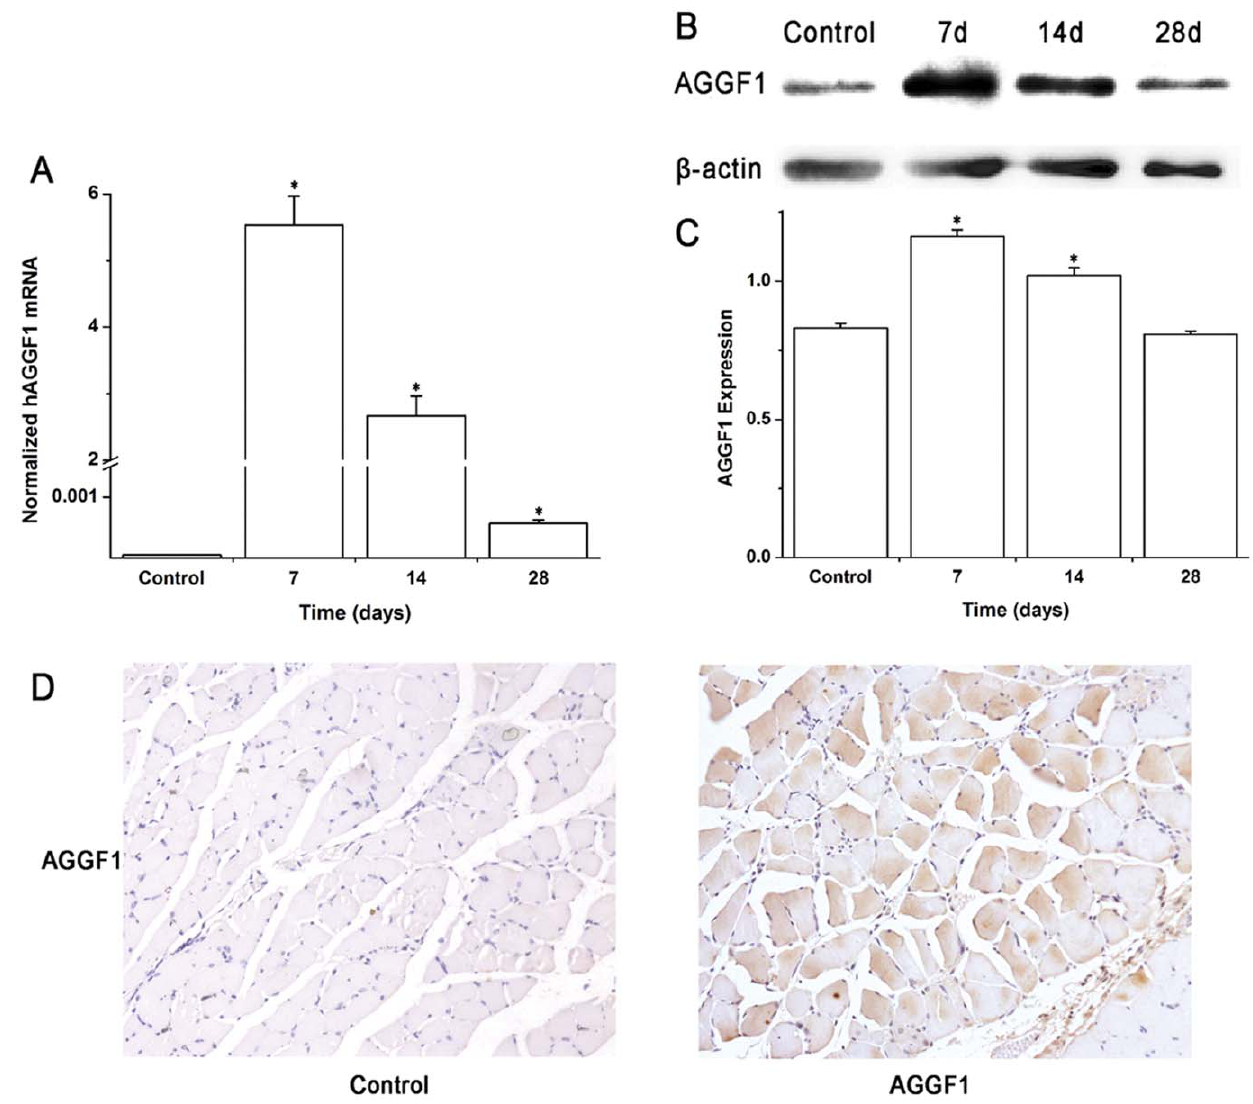
Figure 1. Successful overexpression of AGGF1 mRNA and protein in skeletal muscle by gene transfer using a plasmid-based delivery system. A) Real time PCR analysis for expression of human AGGF1 mRNA derived from an AGGF1 expression plasmid injected into the gastrocnemius muscle in a mouse ischemic hindlimb model. The RT-PCR primers are specific to human AGGF1 and not able to amplify the endogenous mouse AGGF1 mRNA. Time points are in days after the injection of plasmid DNA. Injection of the empty vector DNA served as negative control. The data are shown as the amount of plasmid-derived human AGGF1 mRNA normalized to control GAPDH levels. To avoid the contamination of plasmid DNA, RNA samples were treated with DNase. In addition, RT-PCR analysis with RNA samples without reverse transcription did not yield any product. B ) Expression of AGGF1 protein in gastrocnemius muscles by Western blot analysis at time points of 7, 14, 28 days after plasmid DNA was injected. The anti-AGGF1 antibody recognizes both human AGGF1 derived from the injected plasmid and endogenous mouse AGGF1 protein. C ) The images from Western blot analysis in B ) were scanned, quantified, and plotted. The intensity of AGGF1 signal was normalized to the signal of control b -actin. D ) Immunohistochemical analysis of the sections of ischemic hindlimb muscle from mice injected with an empty vector (Control) and with an AGGF1 expression plasmid (AGGF1) with an anti-AGGF1 antibody seven days later by injection of plasmid DNA. *, P , 0.05.